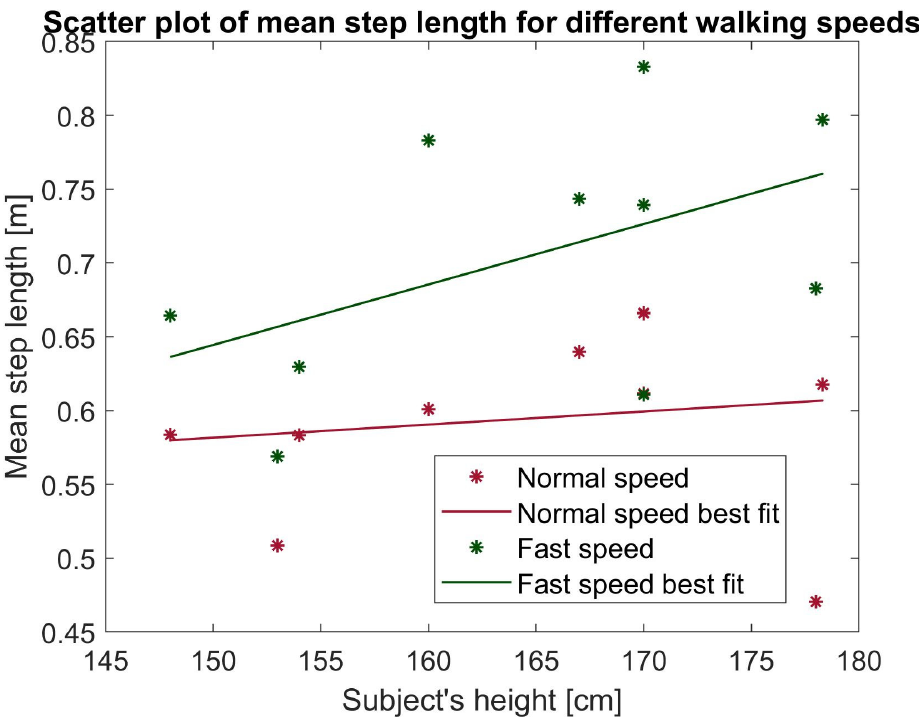
Figure 14. Correlation of subject’s height and step length for normal walking speed and fast walking speed.